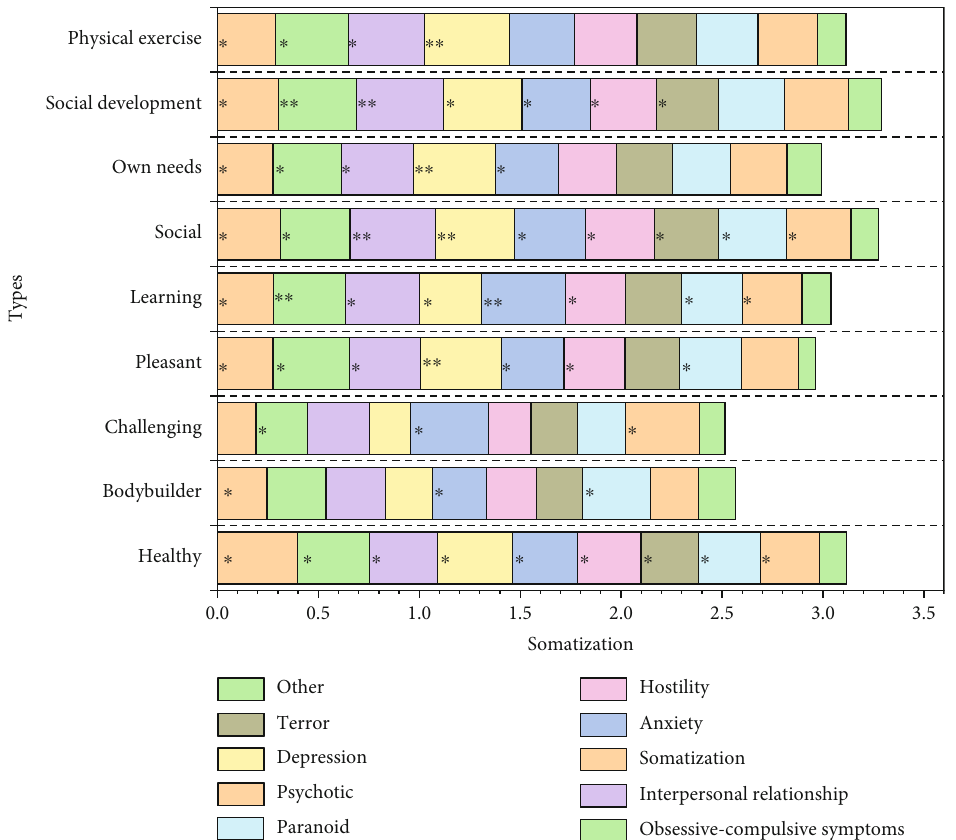
Figure 11: Correlation analysis chart between physical exercise methods and self-evaluation results of disease belief ( ∗ indicates p < 0 : 05 , and ∗∗ means p < 0 : 01